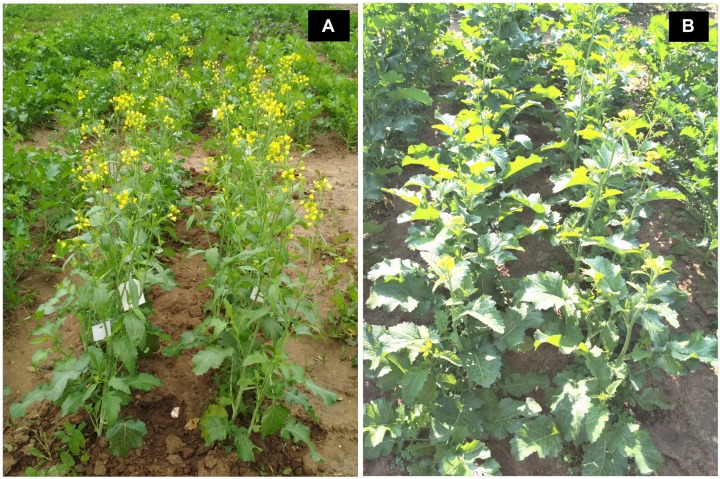
Field photographs showing plant morphology of (A) natural Brassica juncea as compared to (B)
B. juncea–E. cardaminoides introgression line.